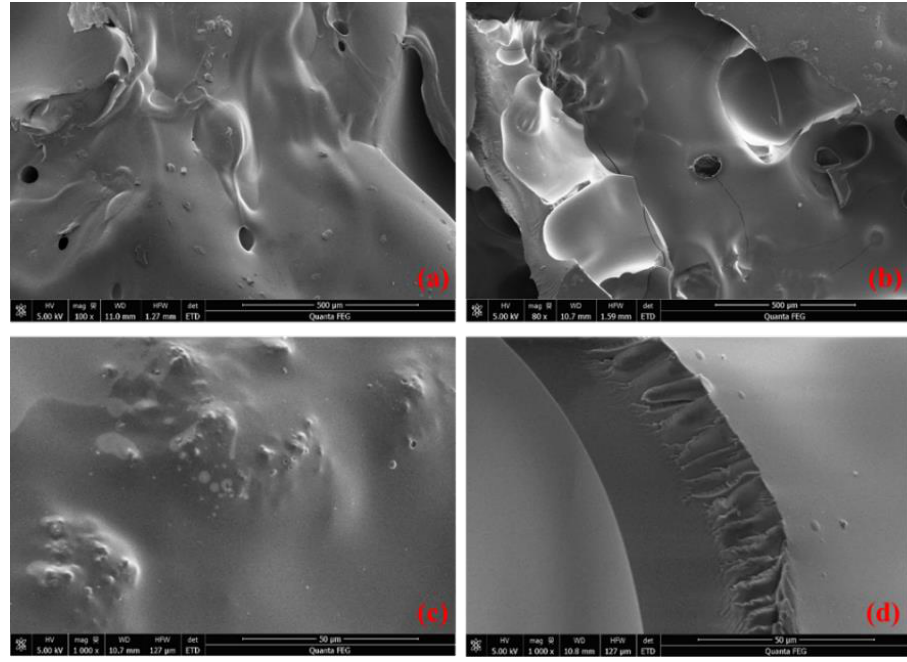
Figure 7. SEM images of silicone resin: ( a ) and ( b ) air pockets on silicone surface, ( c ) surface of silicone at 1000 magnification, ( d ) cross section at 1000 magnification.